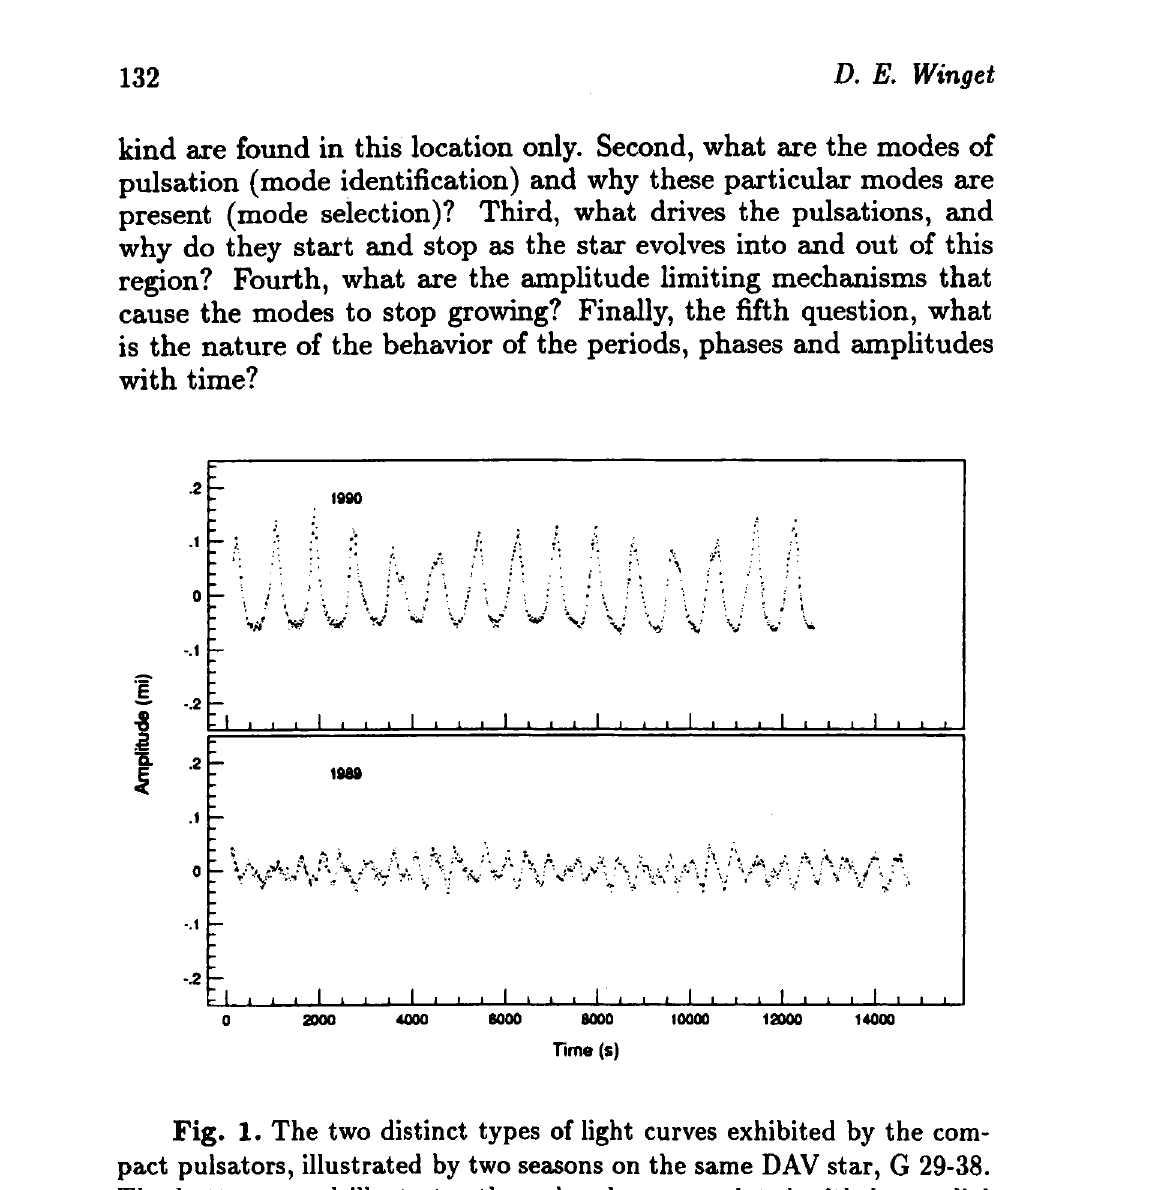
Fig. 1. The two distinct types of light curves exhibited by the com- pact pulsators, illustrated by two seasons on the same DAV star, G 29-38. The bottom panel illustrates the pulse shape associated with low radial overtone pulsations (type I), and the top panel illustrates the pulse shape associated with low radial overtone pulsations (type